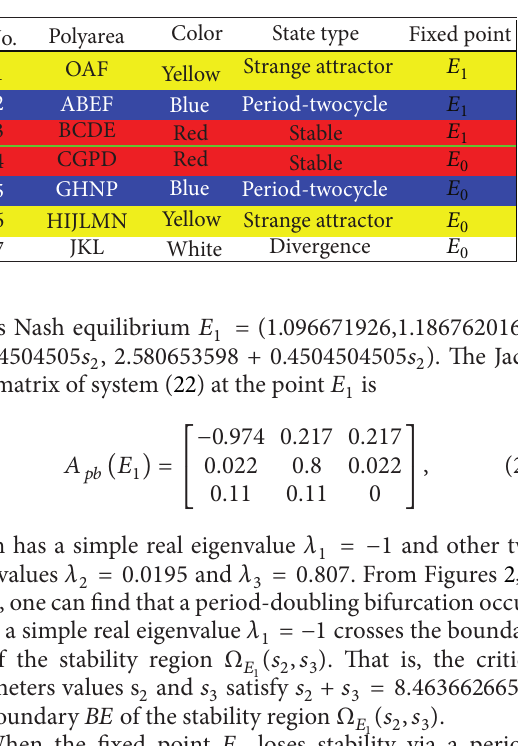
Figure 2: Parameter basin versus the parameters (𝑠 2 , 𝑠 3 ) . Table 1: Legend of the color coding for Figure 2.